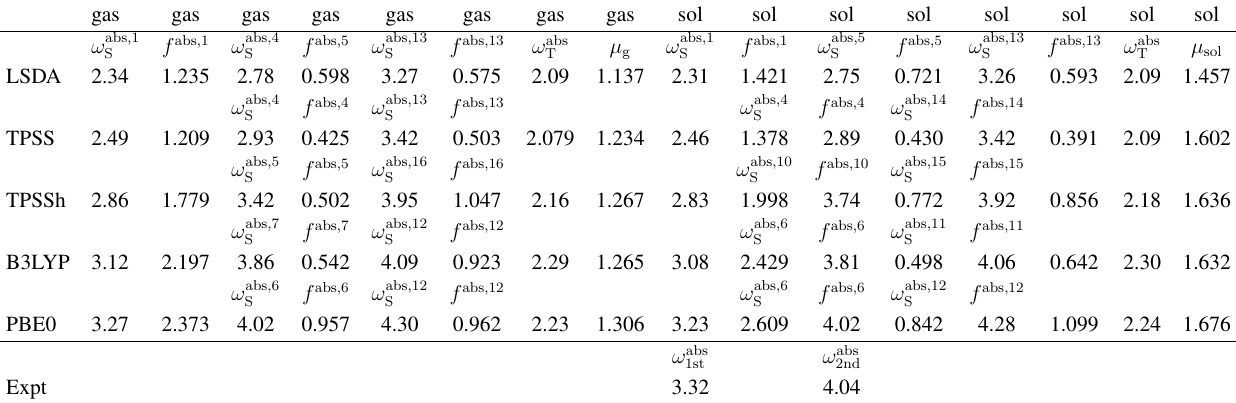
The same as Table 11, but for B3PPQ. The basis set 6-31G(d) is used. Experimental values measured in chloroform are obtained from Ref.